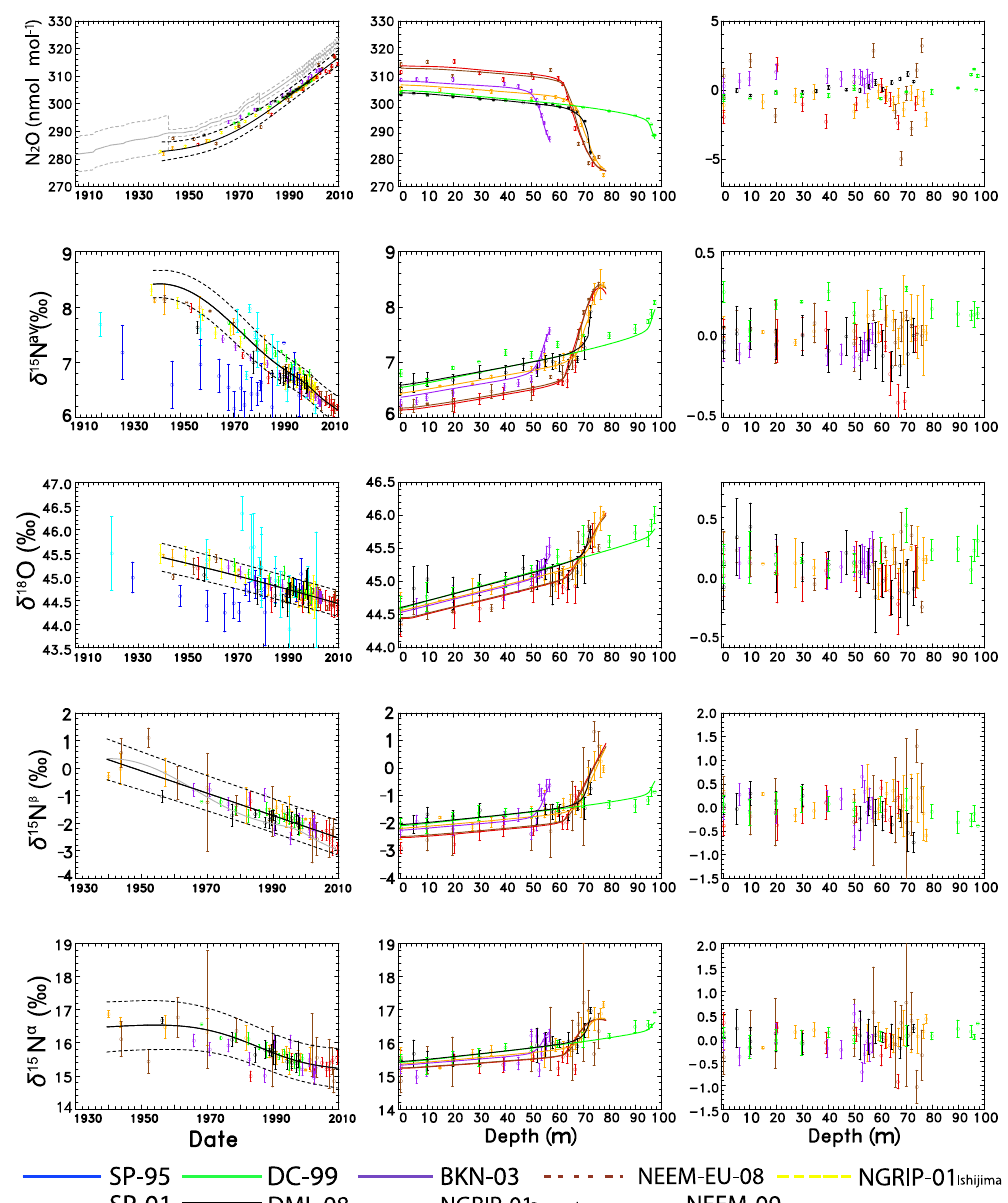
Figure C2. Results of the firn data evaluation (similar to Fig. 2) using the data re-scaled to the NEEM-09 site. Colors as in Fig.